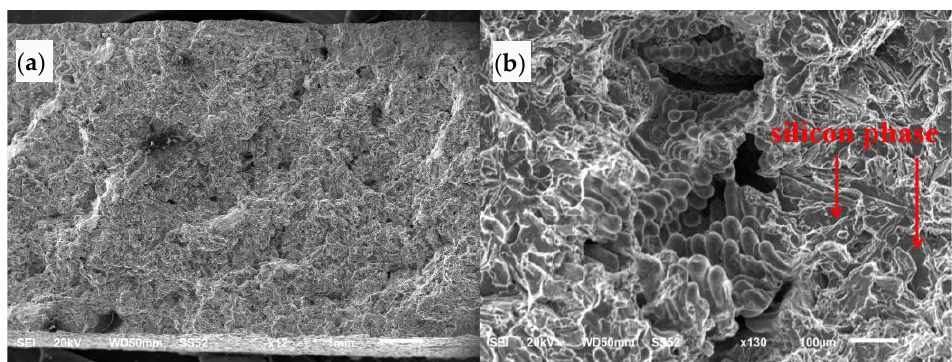
Figure 8. SEM morphology of crack propagation zone: ( a ) low magnification, ( b ) high magnification.